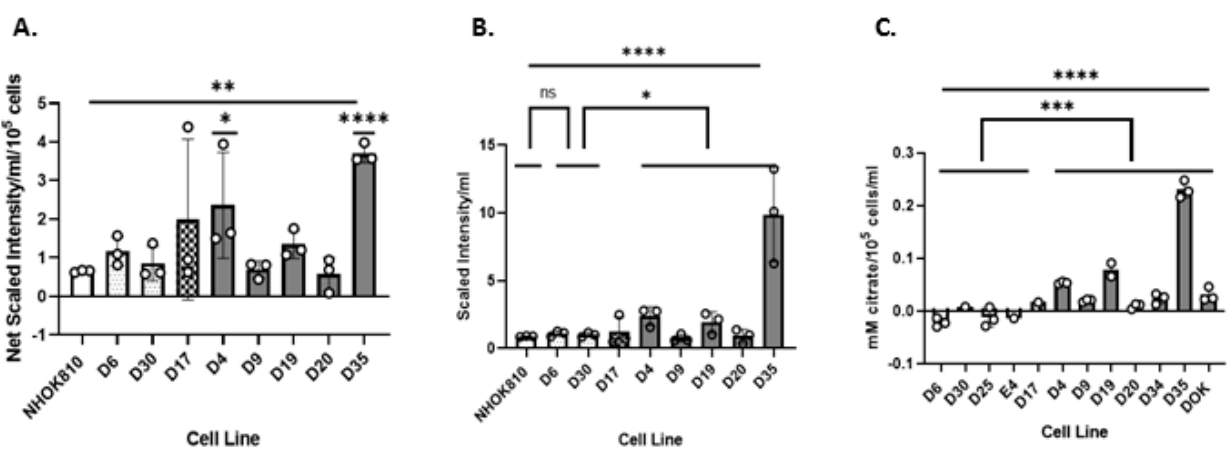
Figure 9. Levels of extracellular citrate are consistently elevated in HR IPPOL keratinocytes relative to LR MPPOL and normal keratinocytes. ( A ) The bar charts show citrate levels from the unbiased metabolic screen. The data are the results of three independent experiments +/ − standard deviation derived from one line of healthy normal keratinocytes, two lines of LR MPPOL keratinocytes, D17 (p16 INK4A − / − ), and five lines of HR IPPOL keratinocytes. The data are concentrations not normalised for cell number or protein, but are from cultures of equal surface area and presented as scaled intensity. White bar = normal oral keratinocytes; stippled bars = LR PPOL keratinocytes; hatched bars = D17 (p16 INK4A − / − ) keratinocytes; and dark grey bars = HR IPPOL keratinocytes. Significant by one-way ANOVA (bar) or Welch’s Test relative to NHOK810 (bars over individual cell line bars) * p < 0.05; ** p < 0.01; and *** p < 0.001. ( B ) The data are the same as for ( A ), but with the background subtracted and normalised for cell number. The data are presented as net scaled intensity/10 5 cells/mL. Significant by one way ANOVA (straight bar). Welch’s Test was used to compare LR MPPOL (D6 and D30) with HR IPPOL lines D4, D9, D19, D20, and D35 linked bars) * p < 0.05; ** p < 0.01; and *** p < 0.001. ( C ) The bar charts show citrate levels using targeted metabolomics analysis. The data are the results of between one (D30, E4, and D17) and three (rest) independent experiments +/ − standard deviation derived from four lines of LR MPPOL keratinocytes, D17 (p16 INK4A − / − ), and seven lines of HR IPPOL keratinocytes with the background subtracted and normalised for cell number. The data are presented as mM citrate/10 5 cells/mL. Symbols are the same as in ( A , B ). Significant by one-way ANOVA (bar). Welch’s Test was used to compare LR MPPOL (D6, D25, E4, and D30) with HR IPPOL lines D4, D9, D19, D20, D34, DOK, and D35 linked bars) ** p < 0.01; *** p < 0.001; and **** p < 0.0001. D4 ***, D9 **, D20 **, D34 **, D35 ****, and DOK ** were all individually significant from D6 by the unpaired Student’s t test.